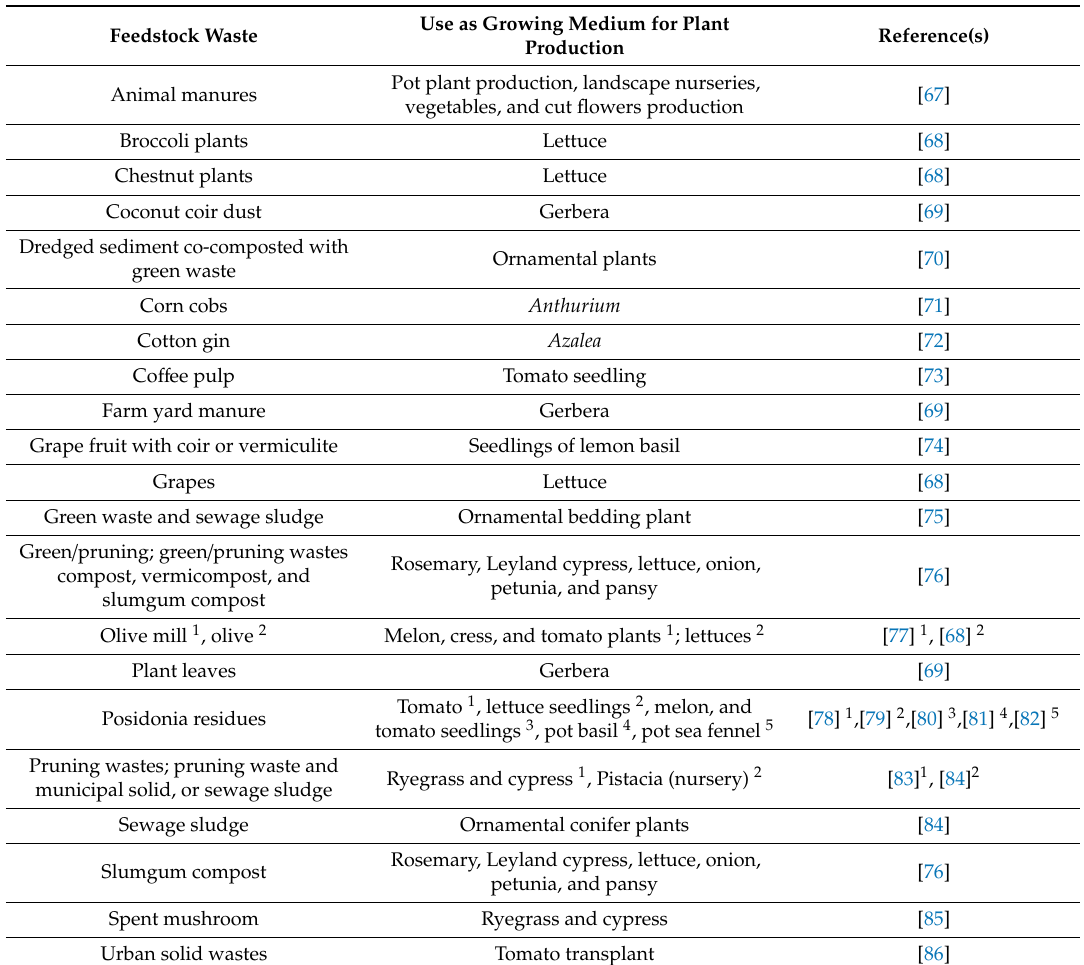
Table 1. Waste materials used for compost, which, in turn, is used as a plant substrate on its own or in a mixture with other